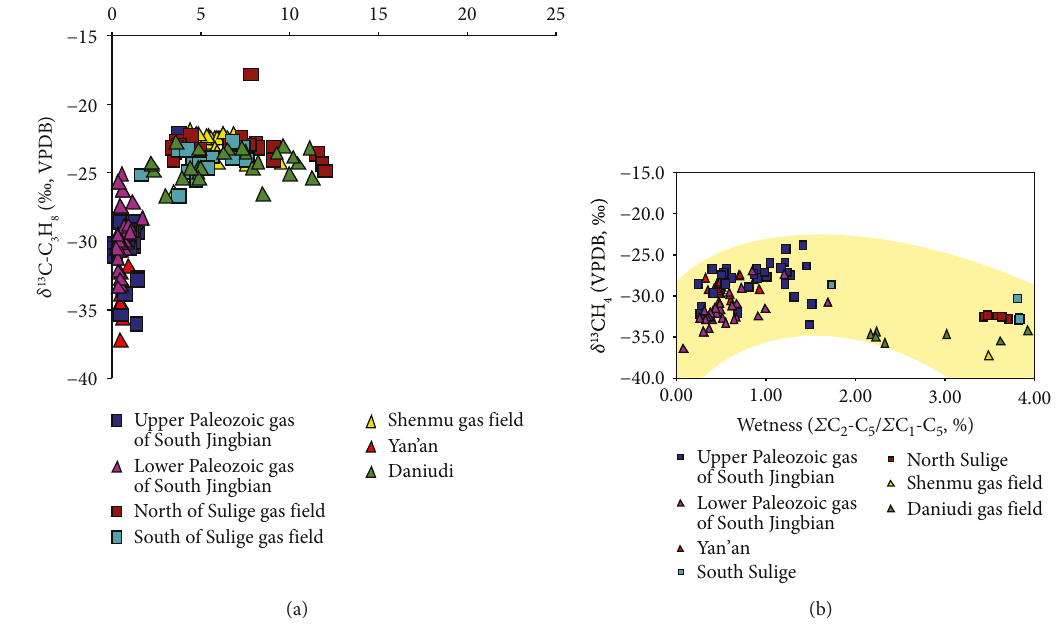
Figure 10: (a) δ 13 C-C of 0% – 4%.